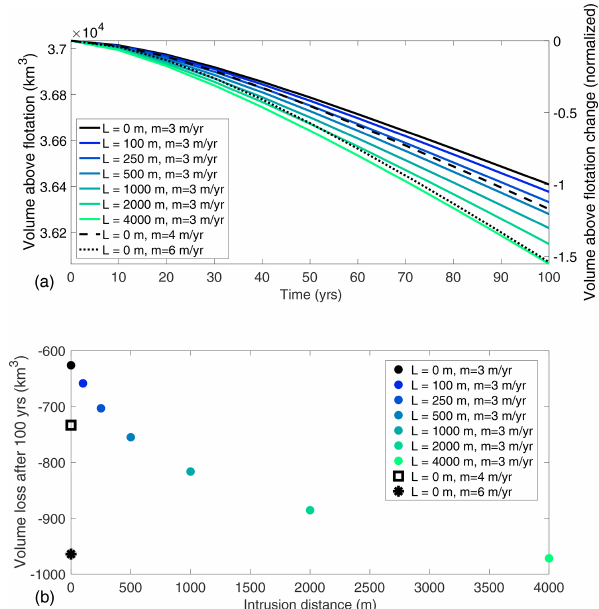
Figure 7. ISSM simulations of transient ice volume loss in the MISMIP+ configuration over 100 years with varying distances of “low” ( ˙ m GL = 3myr − 1 ) intrusion-induced basal melt upstream of the grounding line and increased submarine melt rates with no intru- sion for comparison. (a) Transient ice volume loss over 100 years. Color variation shows different prescribed intrusion distances, and dashed and dotted lines show higher submarine melt rates with no intrusion. (b) Total ice volume loss at the end of 100 years as a function of intrusion